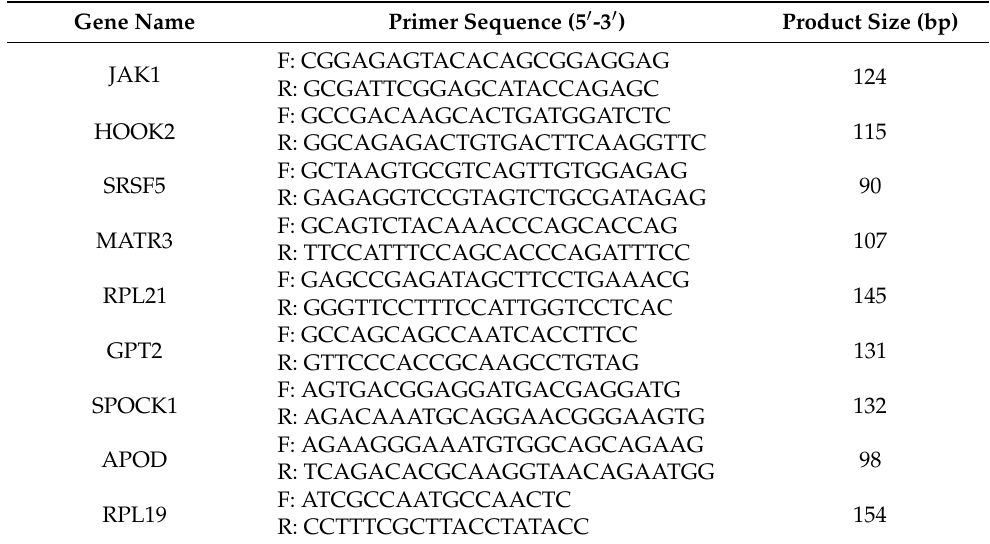
Table 1. Primers were designed for expression analysis in this study.